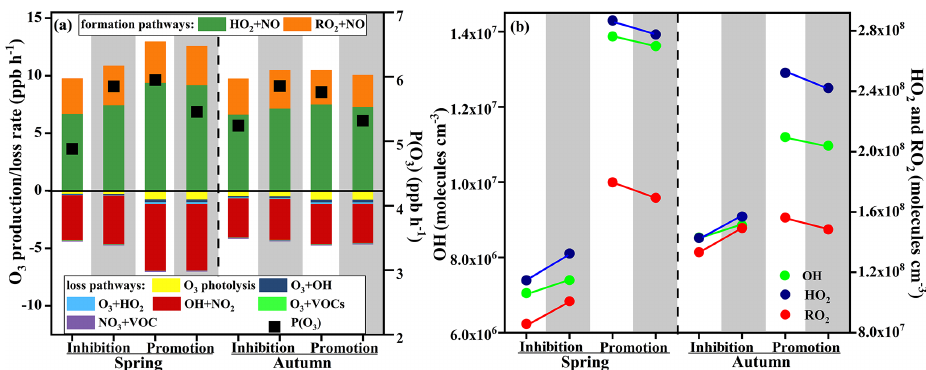
Figure 8. Model-simulated (a) net O 3 production rate and O 3 budgets, (b) OH, HO 2 , and RO 2 on the inhibition effect stages and promotion effect stages. Note: the white background parts represent the SC1 scenarios using the MCM mechanism, and the grey background parts represent the SC2 scenarios using the MCM mechanism with PAN chemistry